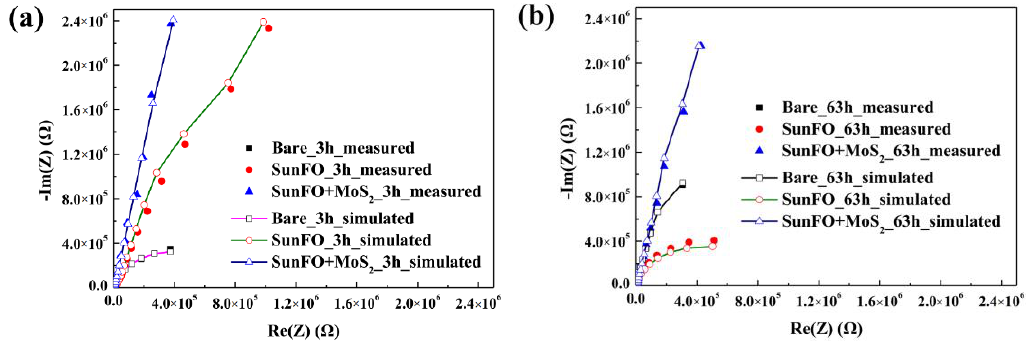
Figure 7. Time-dependent EIS results in the form of Nyquist plot in 3.5% NaCl solution: ( a ) initial stage (3 h), ( b ) final stage (63 h).